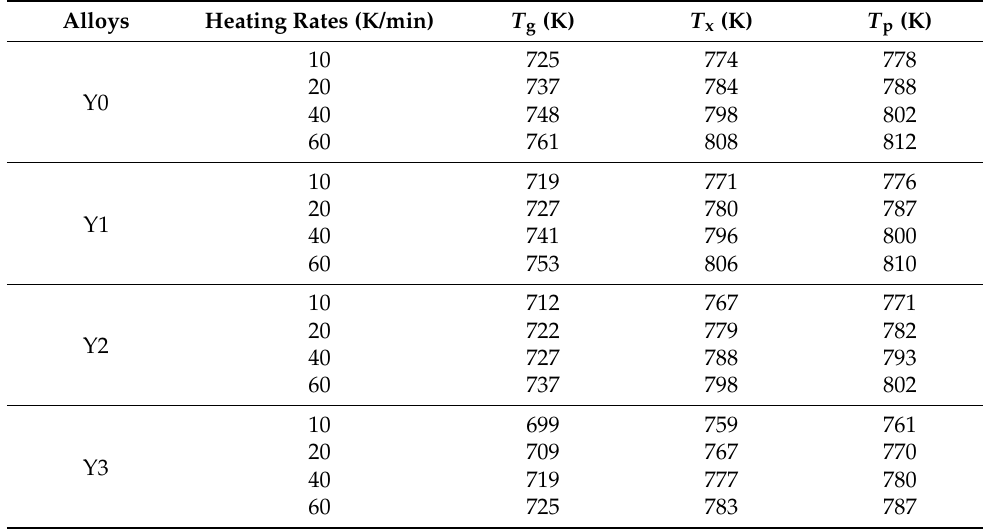
Table 2. T x and T p values of the Y0, Y1, Y2 and Y3 alloys under different heating